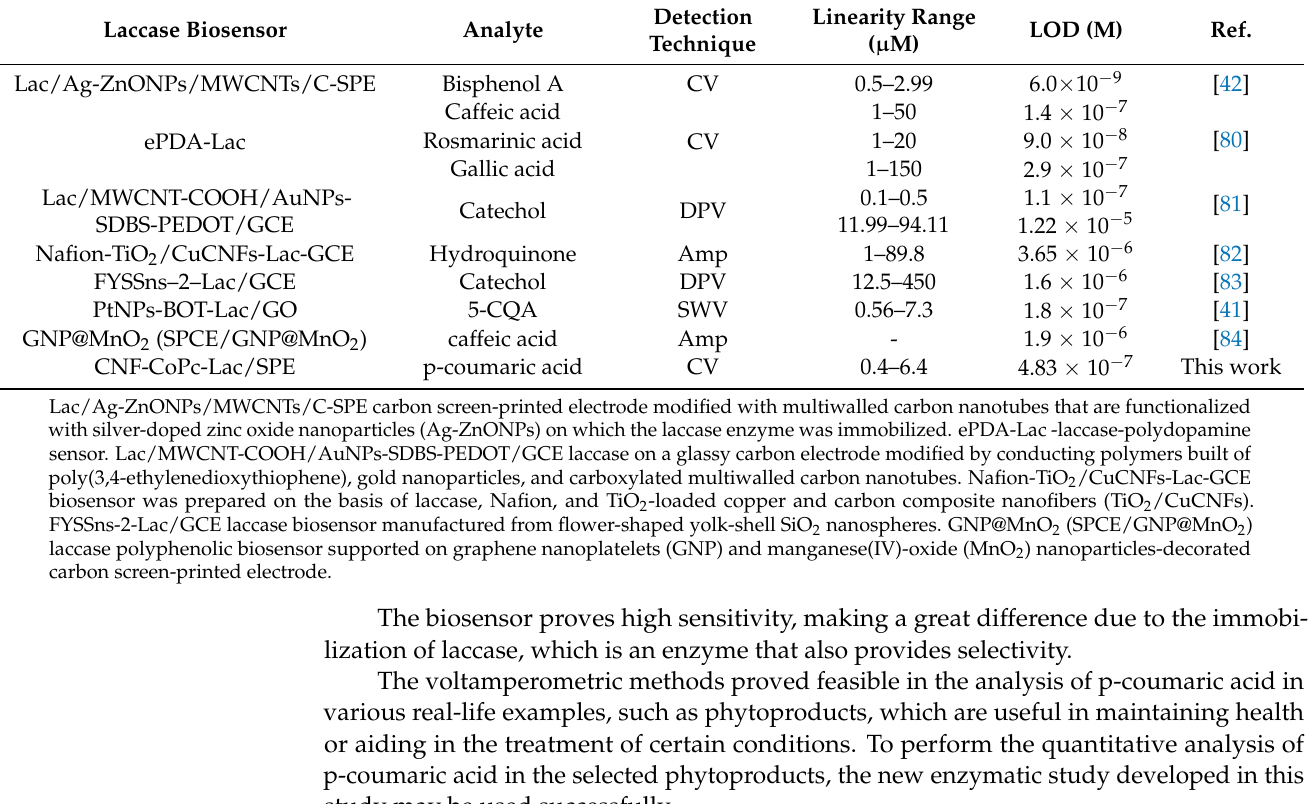
Table 4. Phenolic compounds, detection technique, linearity range, and LOD of some laccase-based biosensors. Laccase